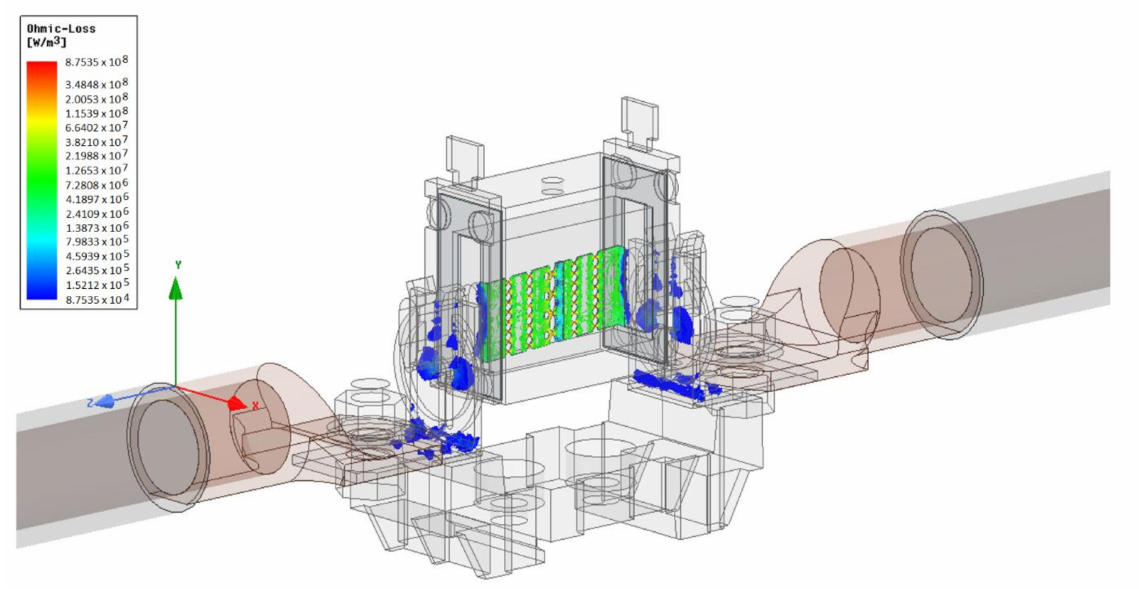
Figure 9. Ohmic losses on the current circuit elements of the fuse model for a rated current of 100